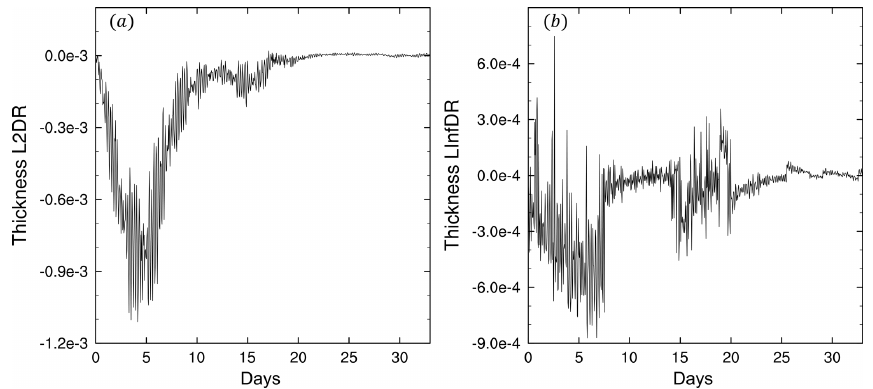
Figure 6. The different ratios of fluid thickness error norms of SWTC6. (a) L 2 error norm difference ratio; (b) L ∞ error norm difference ratio. The model mesh is